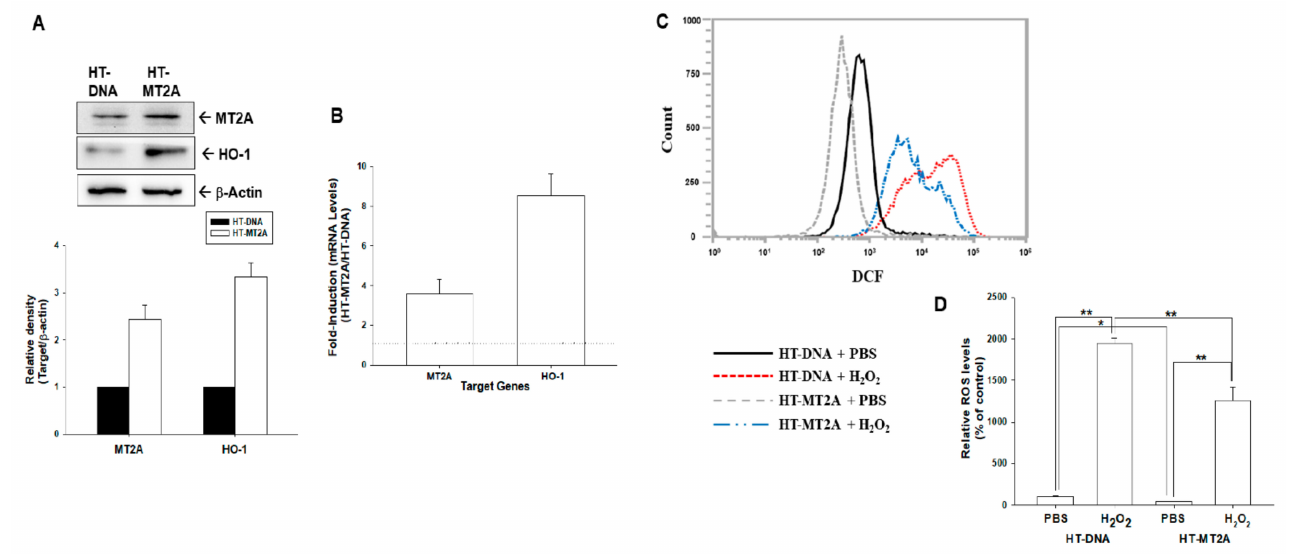
Figure 4. MT2A downregulated H 2 O 2 -induced ROS in bladder carcinoma HT1376 cells. ( A ) Pro- tein levels of MT2A and HO-1 after overexpression of MT2A in HT1376 cells were examined by immunoblot assays (top). The quantitative data were presented as the intensity of the protein bands of the target proteins/ β -actin relative to the mock-overexpressed cells (bottom). ( B ) Relative fold- induction of mRNA levels of MT2A and HO-1 in HT-MT2A cells compared with HT-DNA cells was evaluated by RT-qPCR assays. ROS levels ( C ) and quantitative data ( D ) of HT-DNA and HT-MT2A cells after treatment with or without H 2 O 2 were measured by flow cytometry. * p < 0.05; ** p <